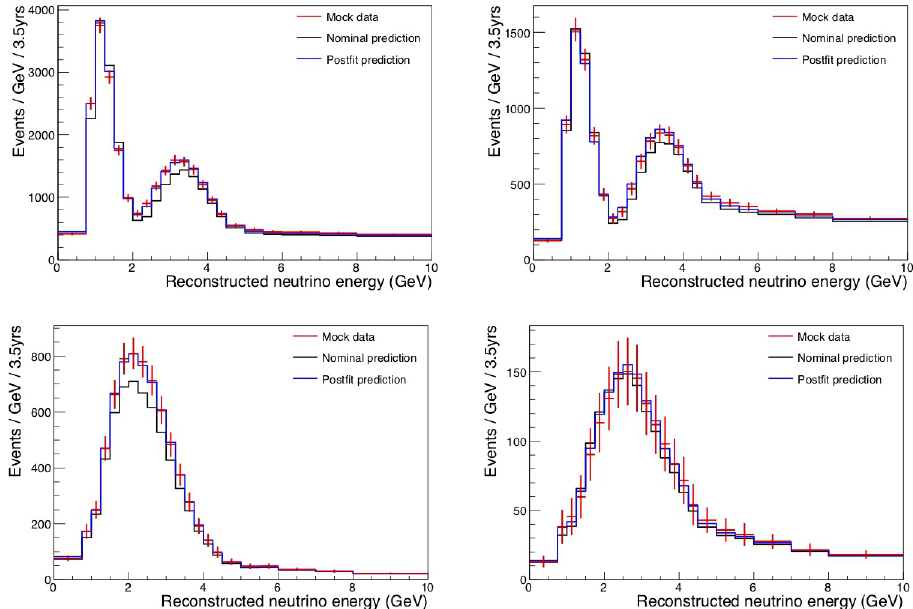
Figure 98. Predicted distributions of reconstructed neutrino energy for selected ν µ ( top ) and ν e ( bottom ) events, in FHC ( left ) and RHC ( right ) beam modes in 7 years. The black curve shows the nominal GENIE prediction, the red points are the mock data samples, and the blue curve is the post-fit result, where systematic and oscillation parameters are shifted to match the mock data. The ND spectra match the pre-fit prediction by construction and are not shown.